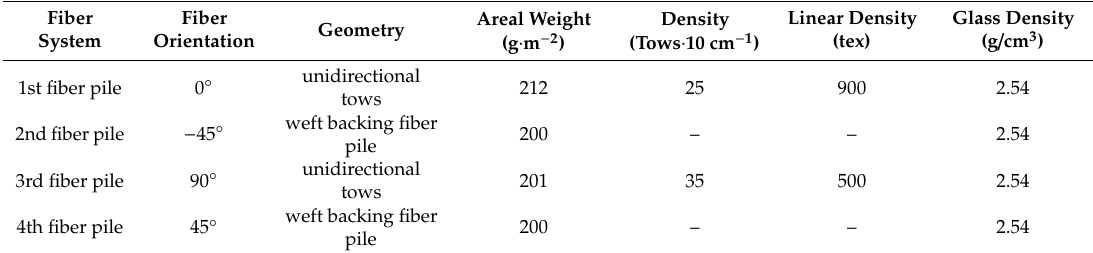
Table 1. Geometric parameters of quadriaxial NCF (E-DBLT800-6).